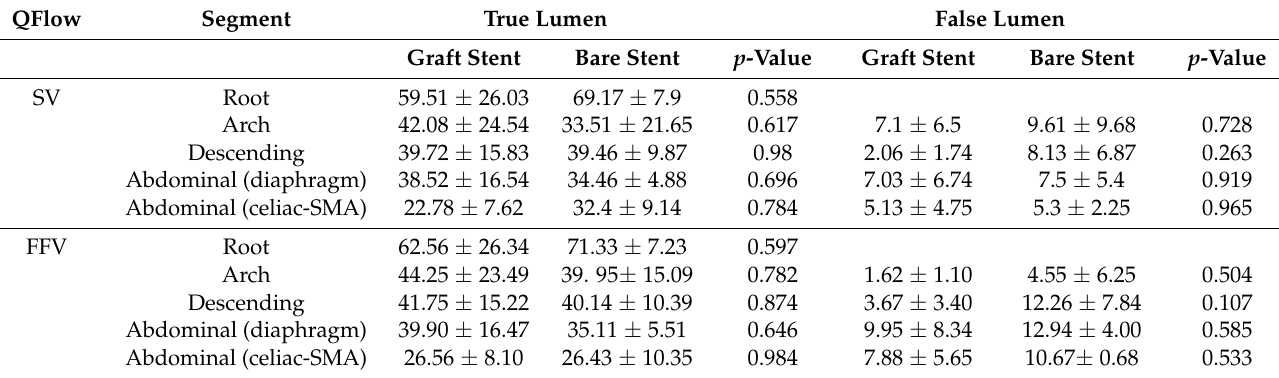
Table 3. Comparison of the QFlow parameters of the subjects using graft stent ( n = 7) and bare stent ( n = 3) after TEVAR. QFlow Segment True Lumen Graft Stent Bare Stent p -Value